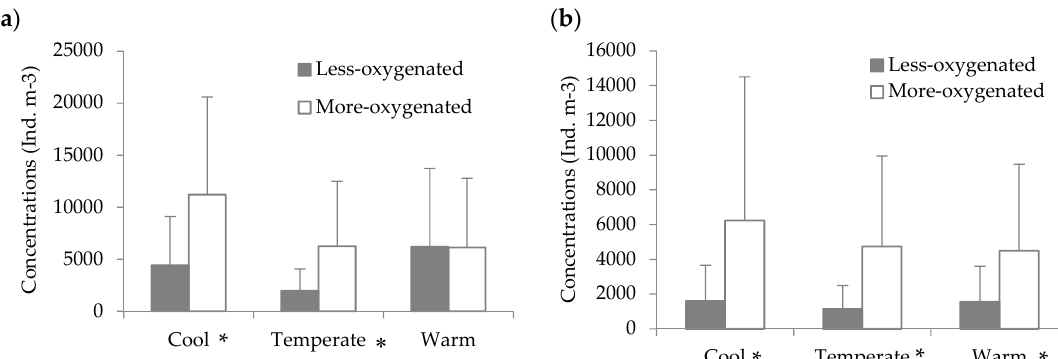
Figure 9. Comparison of copepod (Acartia tonsa) ( a ) adults and ( b ) copepodite concentrations between More-oxygenated (open bar) and Less-oxygenated (closed bar) subgroups within temperature groups (Cool, Temperate, Warm). Error bars indicate standard deviations and * indicates a significant difference in a Kruskal-Wallis test at α = 0.05.